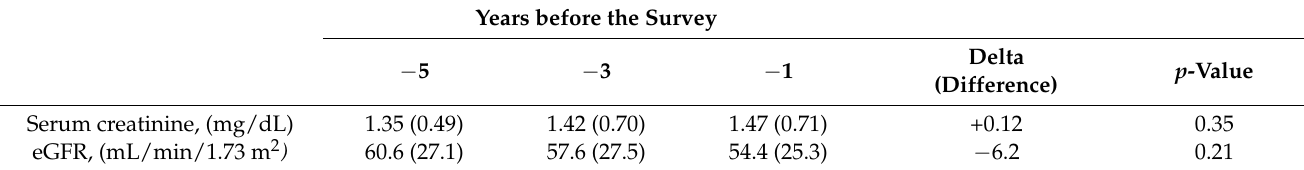
Table 2. Kidney function in CKD group prior to the survey.